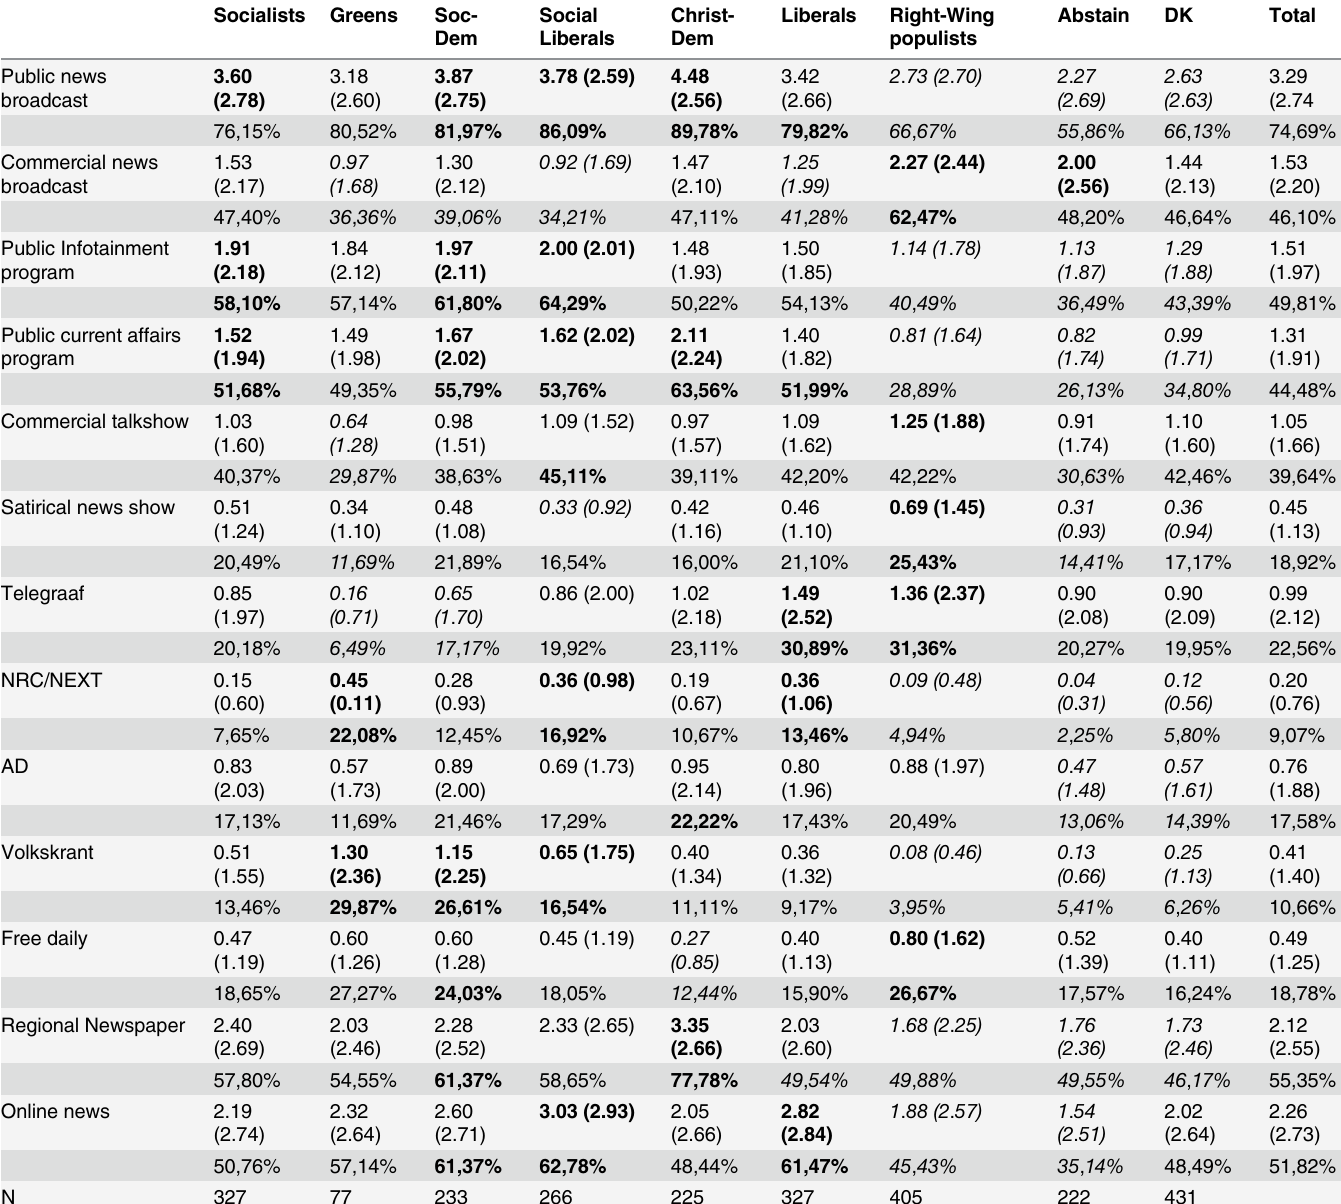
Table 1. Exposure to news sources, related to party